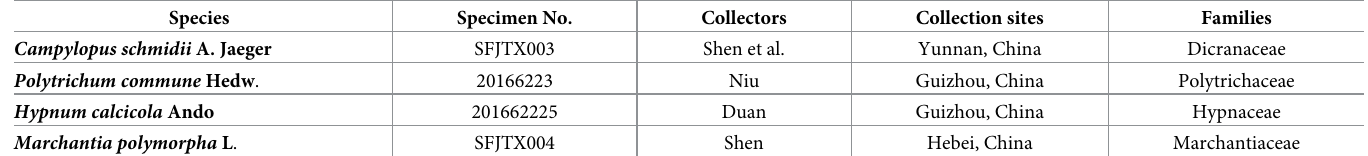
Table 1. The information of voucher specimens.